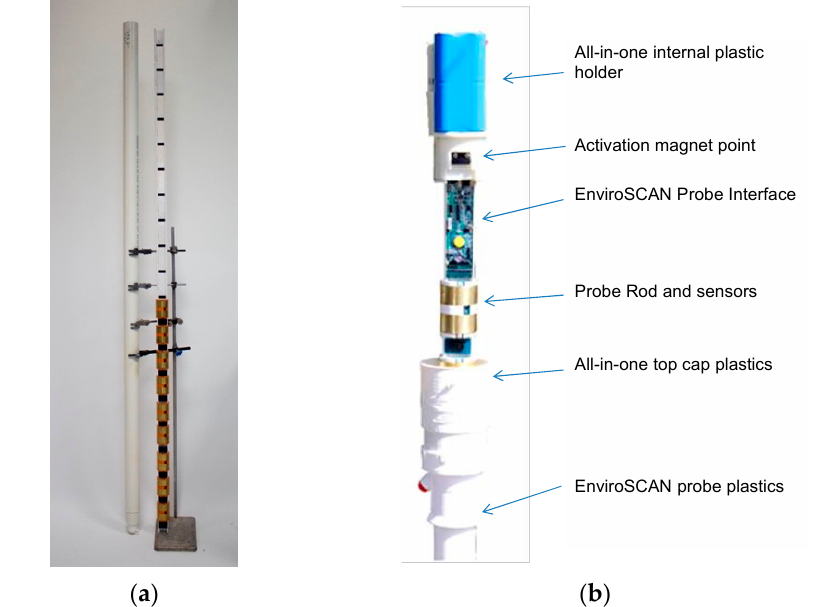
Figure 4. ( a ) The EnviroSCAN probe; ( b ) Probe’s components [44].